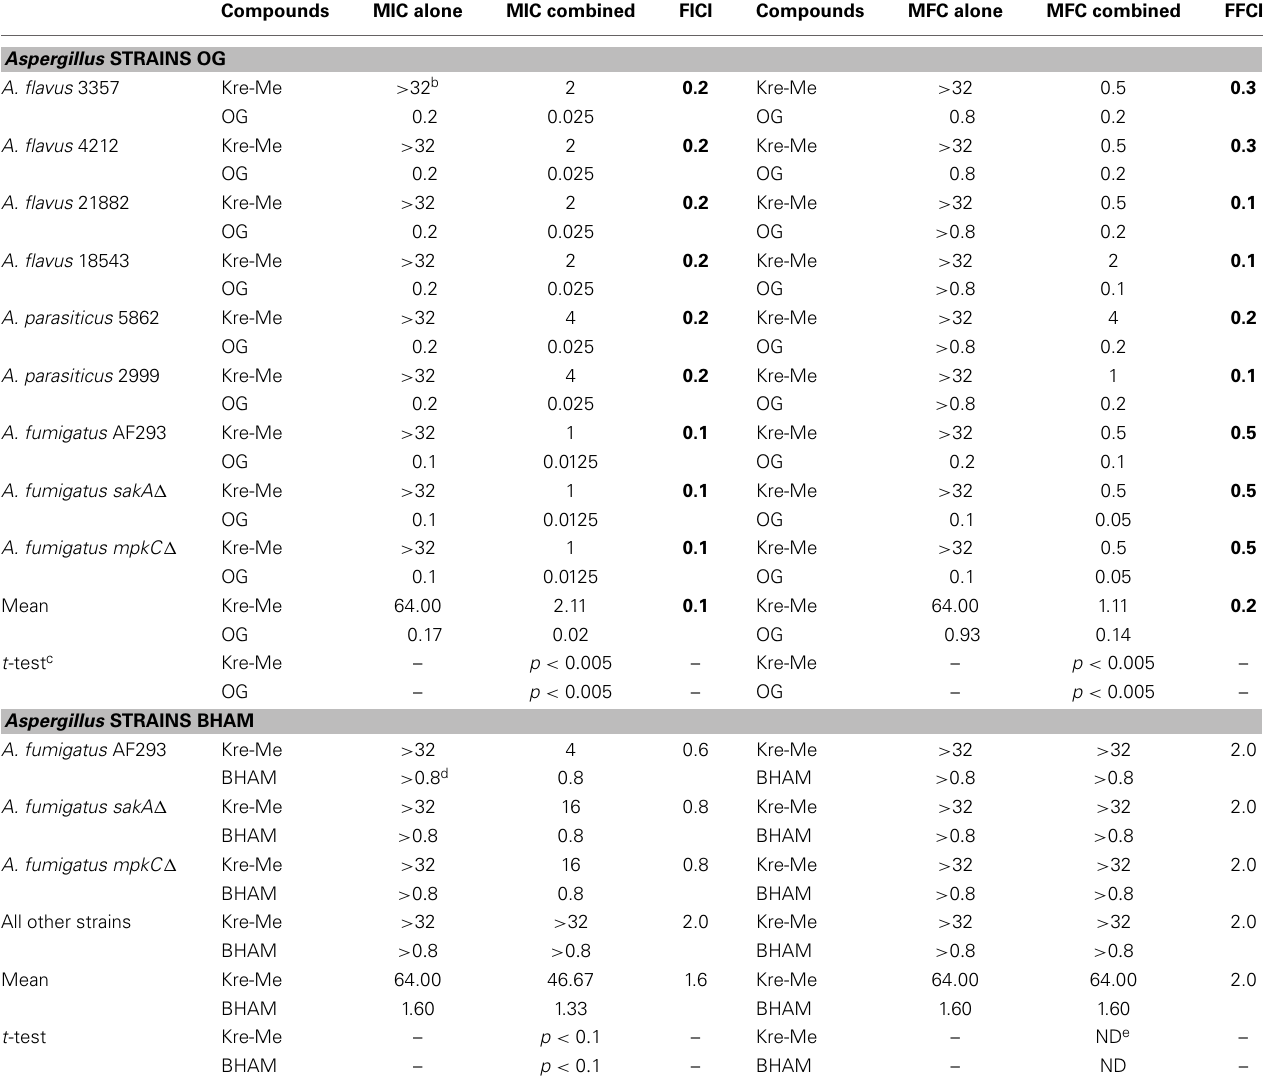
Table 4 | Antifungal chemosensitization of OG (mM) or BHAM (mM) to Kre-Me ( µ g mL − 1 ), tested against Aspergillus strains: summary of CLSI-based microdilution bioassays (48h) a .